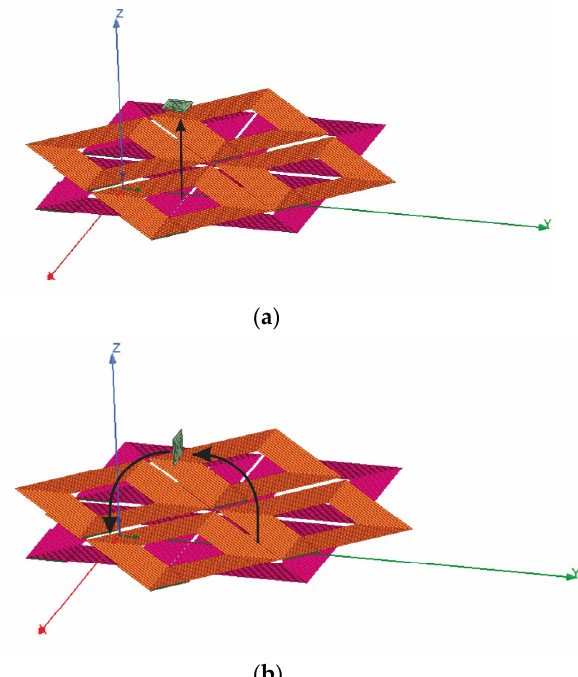
Figure 5. Electromagnetic field simulation using HFSS. The field distribution for ( a ) horizontal and ( b ) vertical RX module.